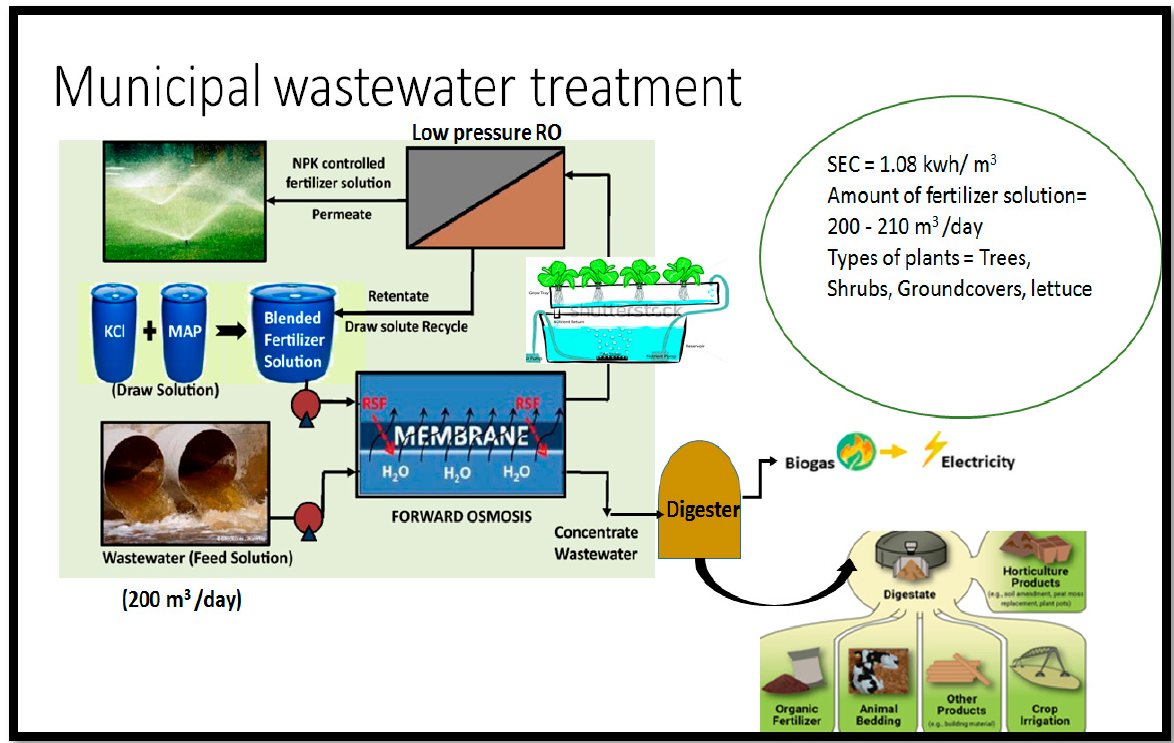
Figure 11. Municipal wastewater treatment fertilizer solution at WD valley.